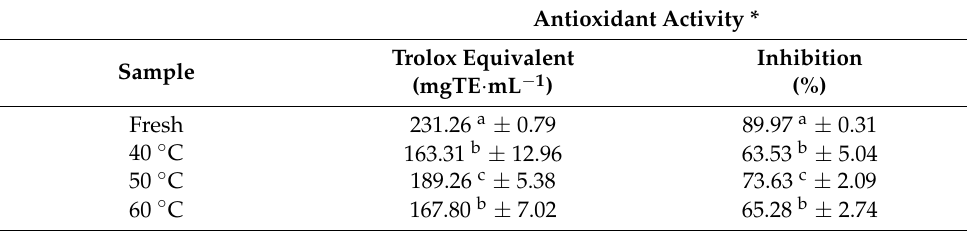
Table 3. Antioxidant activity of the essential oils of the fresh and dried leaves of Lippia thymoides